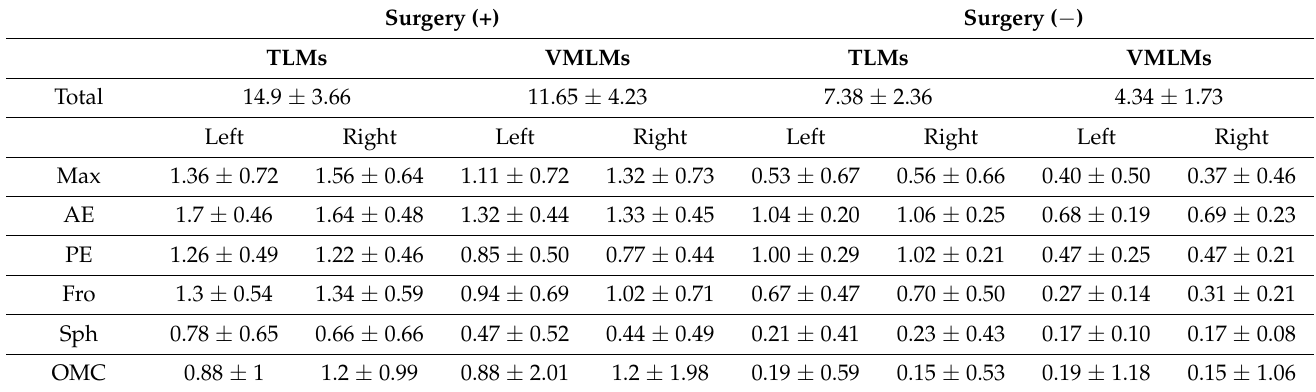
Right Left Right Left Right Left